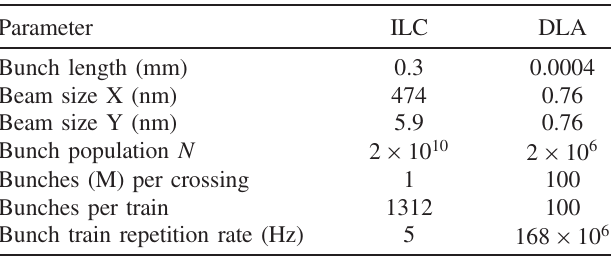
TABLE I. Parameters leading to ILC [1] and DLA [19 – 21] geo- metrical (unenhanced) luminosity rate of at 1 TeV center of mass